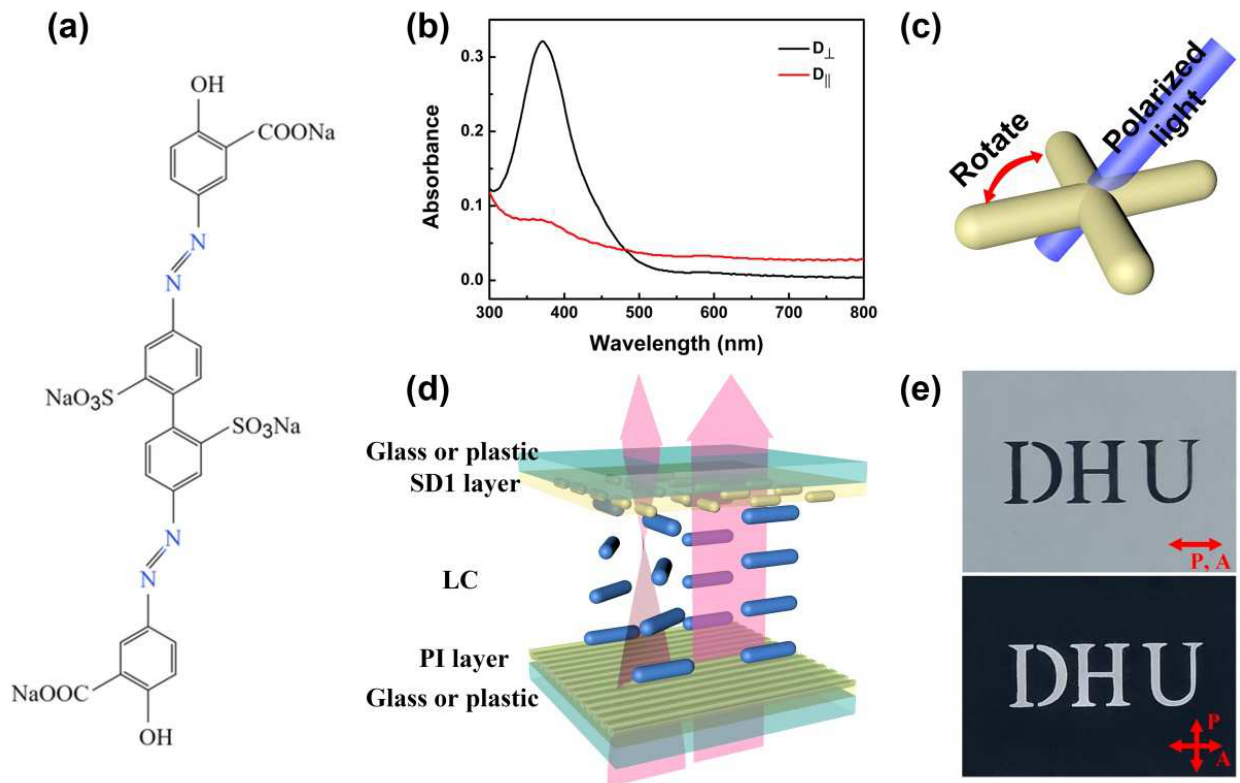
Figure 2. ( a ) Chemical structure of SD1. ( b ) Absorption spectra of SD1 layer after exposure to linearly polarized UV light in the direction parallel (D || ) and perpendicular (D ⊥ ) to the activating light polarization accordingly. ( c ) Schematic diagram of SD1 molecules under linearly polarized UV light. ( d ) Schematic of ODLCD in which two alignment domains with planar alignment (PA) and twisted nematic (TN) domains. ( e ) Digital photographs with a “DHU” pattern between the analyzer and polarizer.